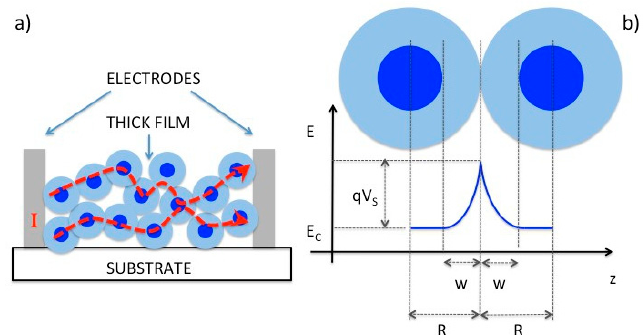
Figure 1. Schematic representation of the structure ( a ) and working principle ( b ) of thick film gas sensors. Reprint from [7].